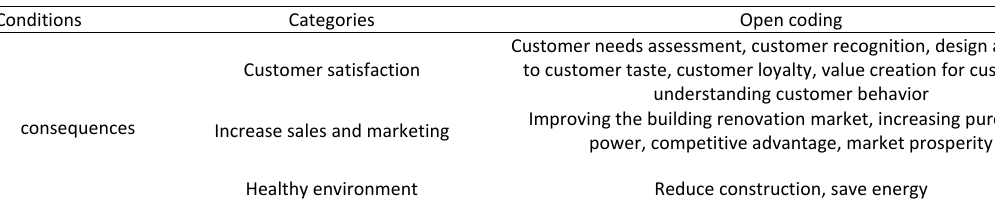
Table 4: Consequences Table 4: